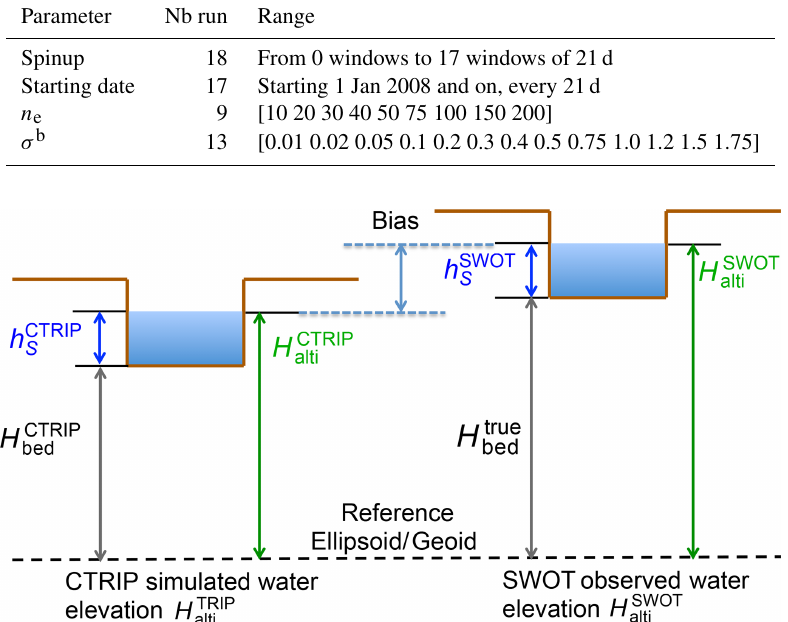
) and the one simulated by CTRIP ( H TRIP alti